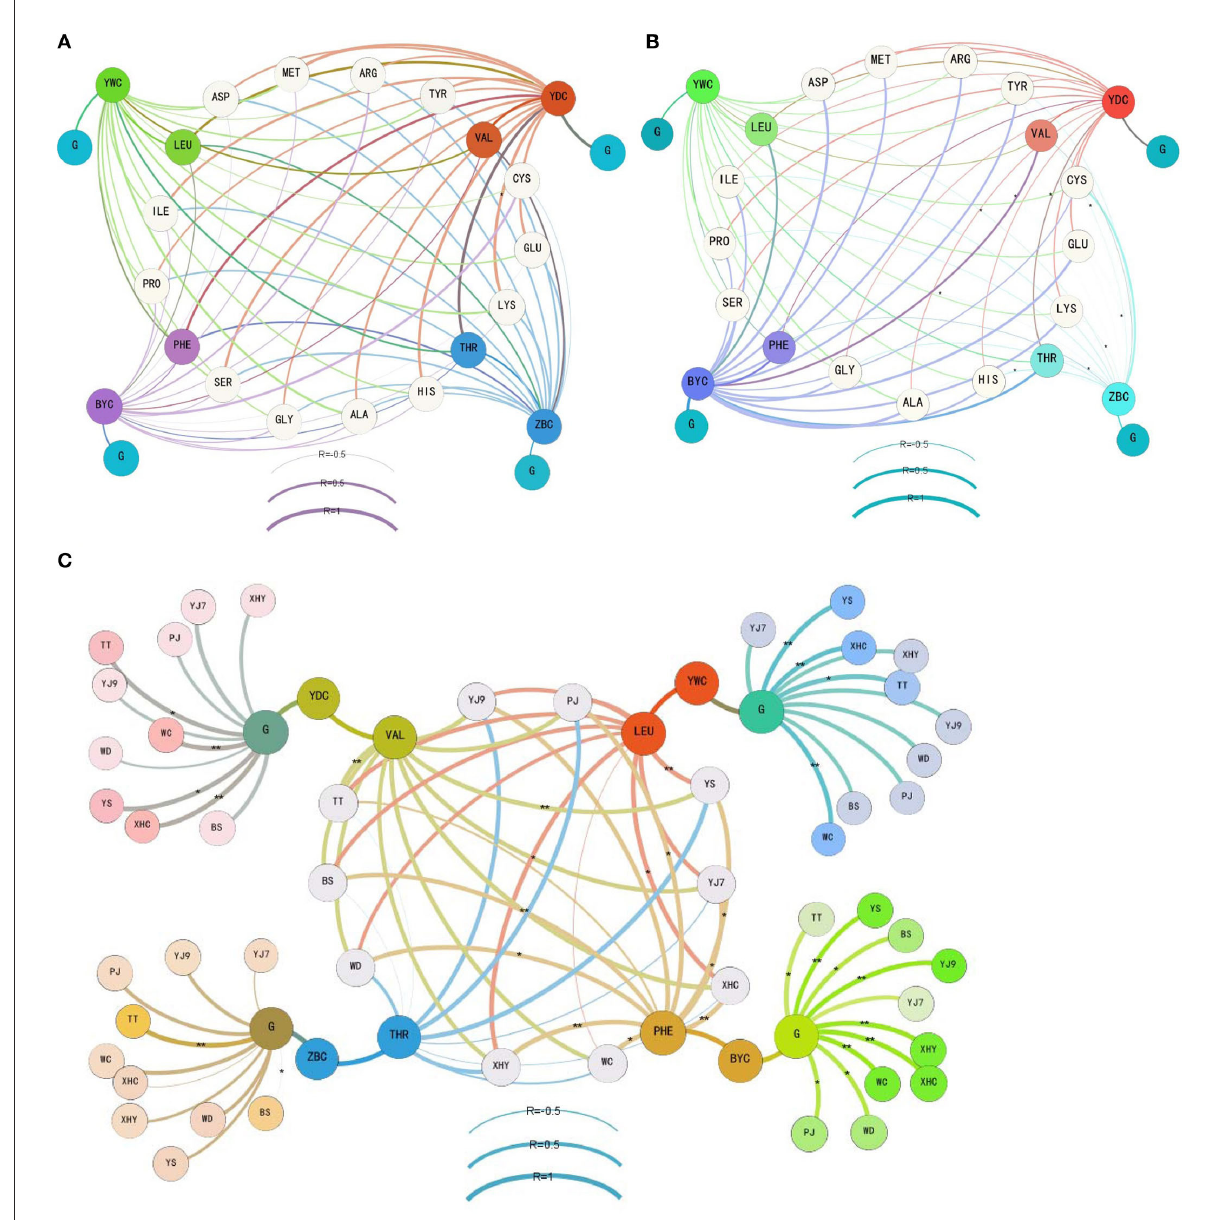
FIGURE2 The correlation between the consumption of glucose and amino acids and the formation of four main higher alcohols during the former (A) , latter (B) , and whole (C) periods of the rice wine fermentations. YWC represents isoamyl alcohol, YDC represents isobutanol, BYC represents phenylethanol, ZBC represents n-propanol, G means glucose, and free amino acids are shown using the abbreviation of three letters. The details of rice cultivars are given in Table 1. *denotes a correlation with significance P < 0.05, and ** denotes a correlation with significance P < 0.01.